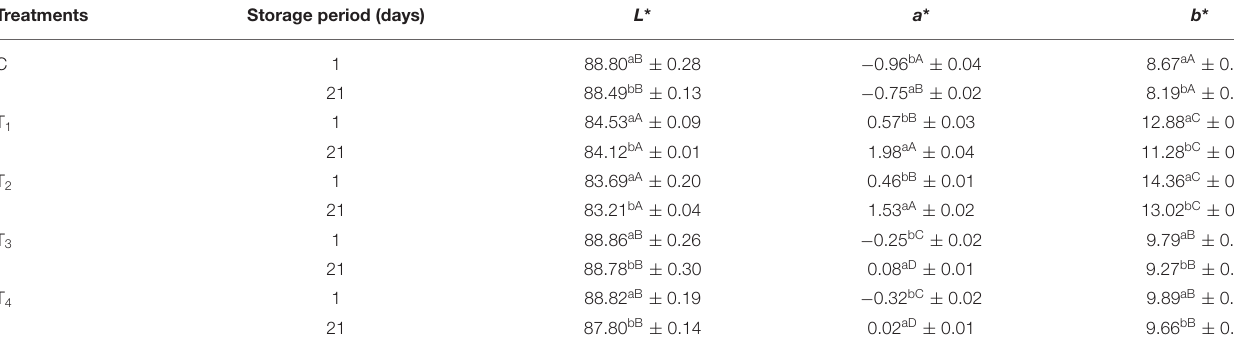
TABLE 3 | Color parameters of SFY.